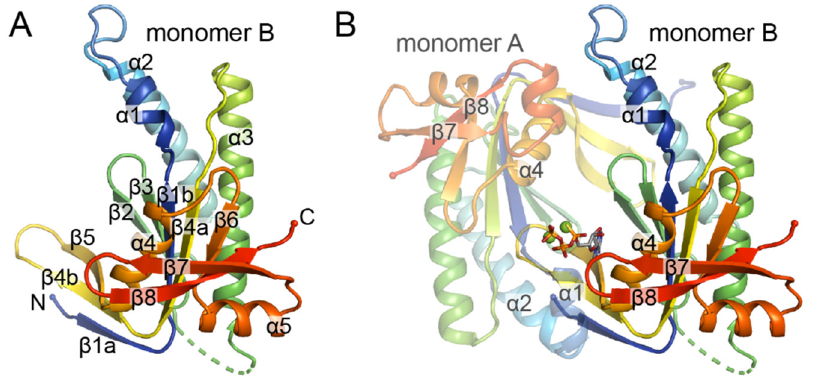
Figure 3. Crystal structures of AC CAT domains serve as a prototype for GC CAT domains. ( A ) Structure of the AC CAT domain monomer (PDB ID 1CJK [59]). Secondary structure elements are labeled according to conventions from the literature [57,58]. Protein is shown in ribbon representation and colored in rainbow mode from N- to C-terminus (termini are shown as small spheres and labeled) with the N-terminus in blue and the C-terminus in red. ( B ) Structure of the AC CAT dimer with ATP and two Mg 2+ ions bound. Each monomer is shown as in panel A with monomer A at 50% transparency. Secondary structural elements that shift upon activation are labeled.